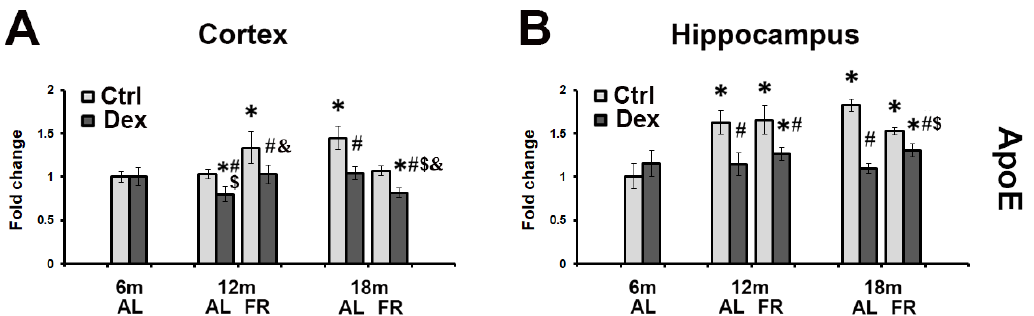
Figure 3. The effects of dexamethasone on ApoE mRNA level in the cortex ( A ) and hippocampus ( B ) of rats fed ad libitum (AL; light gray bars) and following long ‐ term food restriction (FR; dark gray bars) during aging. Dexamethasone was applied in a dose of 4 mg/kg (single i.p. injection). Values were obtained by semiquantitative qRT ‐ PCR. Histogram represents mRNA levels expressed as ratio (fold change) calculated relative to the values obtained in 6 ‐ month ‐ old rats. In order to obtain the differences between the experimental groups, nonparametric Mann–Whitney U Test was performed ( n = 5 rats per group). * p < 0.05 vs. 6 ‐ month ‐ old rats; # p < 0.05 vs. vehi ‐ cle ‐ treated rats, $ p < 0.05 vs. 6 ‐ month ‐ old rats treated with Dex; & p < 0.05 vs. age ‐ matched AL rats treated with Dex.